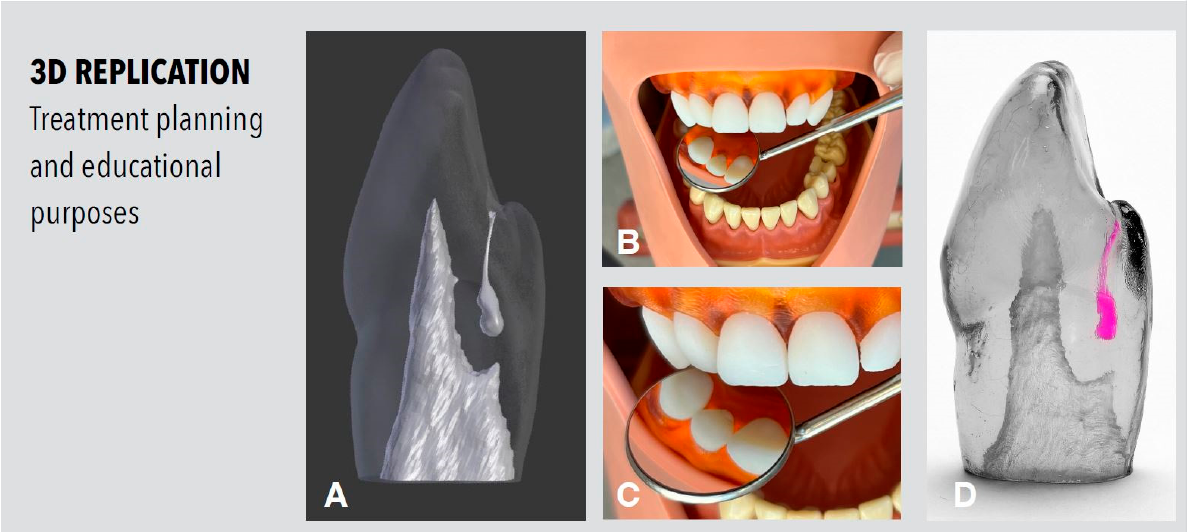
Figure 6. Three-dimensional replication for treatment planning and educational purposes. ( A ) Blender 3D view of the internal anatomy of an Oehlers Type II with a modified invagination. ( B , C ) Three-dimensional-printed replica of tooth 12 for clinical training scenarios in a tooth model and manikin head. ( D ) Transparent and enlarged 3D-printed tooth replica for visualization purposes of the internal root canal anatomy showing the exact location of the pink colored invagination niche.